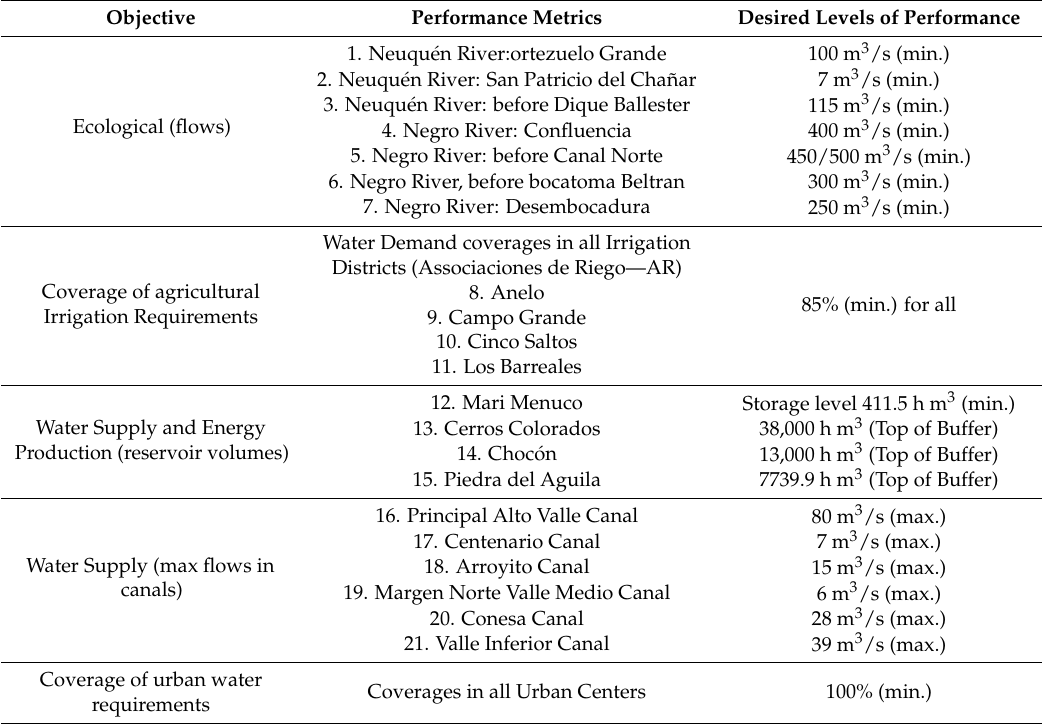
Table 6. List of Performance Metrics (M) identified for the study area and corroborated by the local